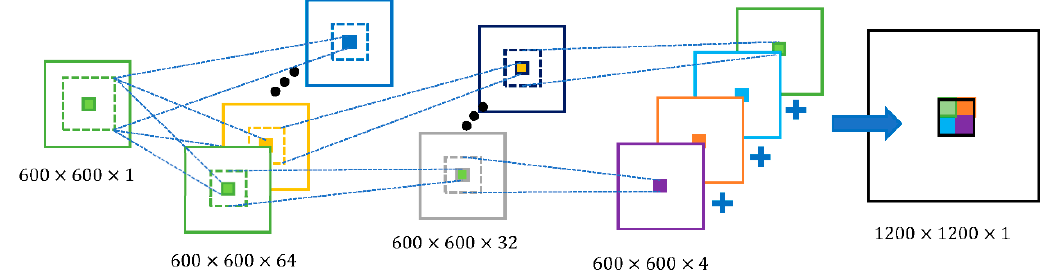
Figure 8. Sketch map of the process of the formation of the SR DEMs.